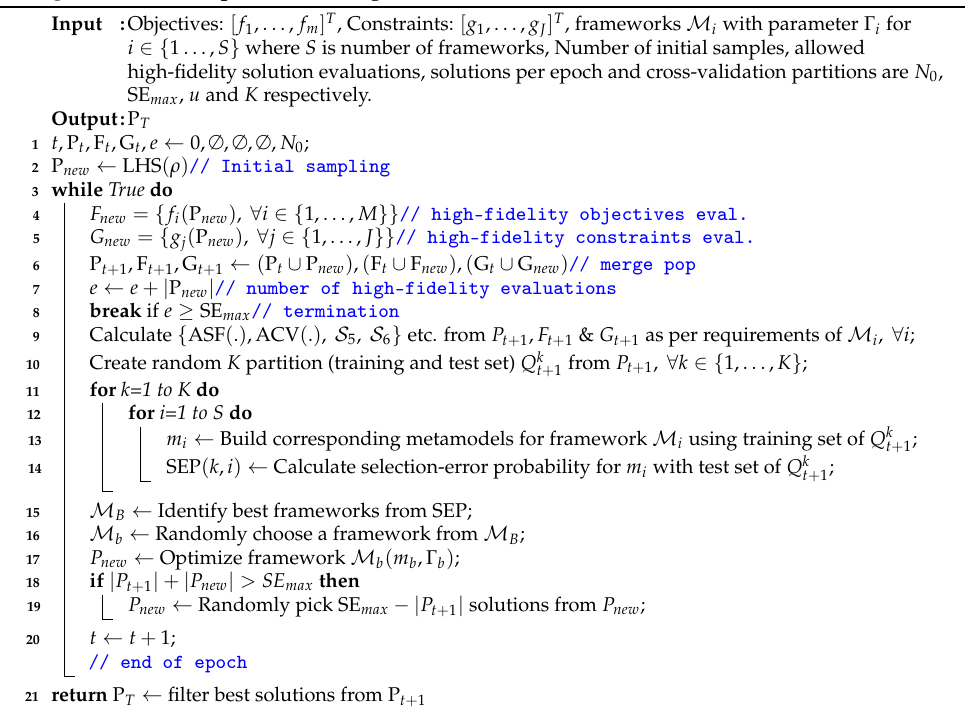
Algorithm 1: Adaptive Swithing